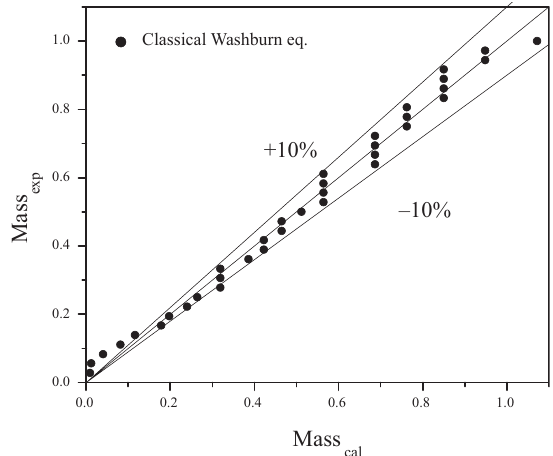
Fig. 12. Correlation between experimental values (mass calculated (mass ) by means of the classical Lucas–Washburn cal equation for the process of porous material imbibition with oil